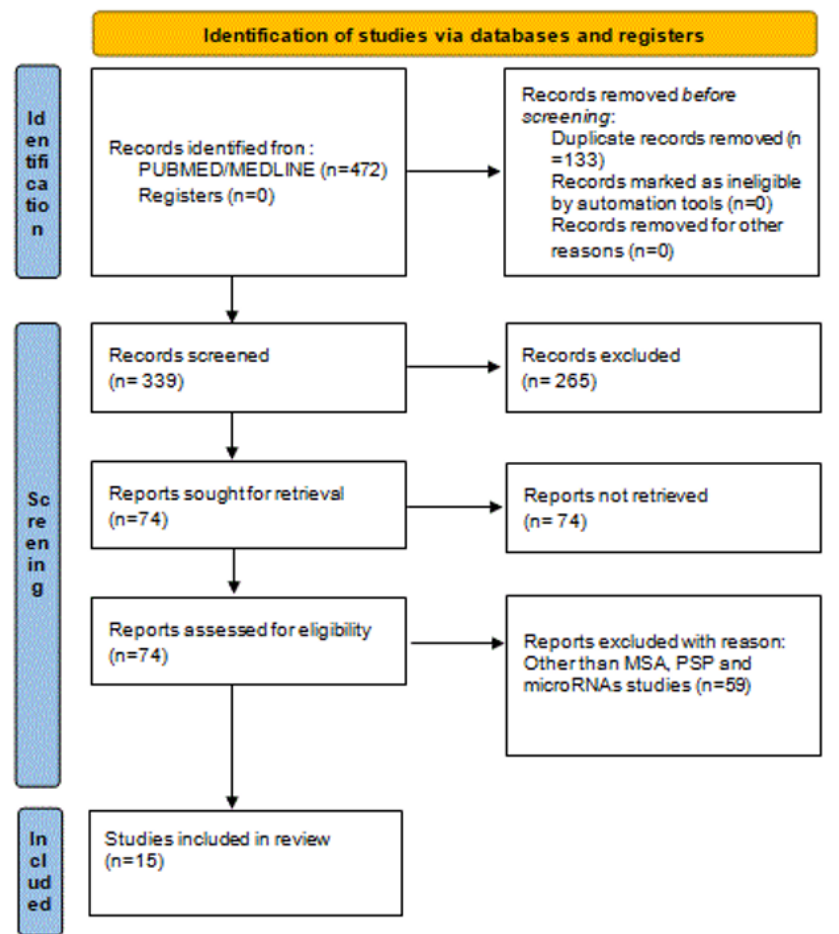
Figure 1. Identification of studies via using PRISMA flow diagram. Abbreviation: MSA: Multisystem Atrophy, PSP: Progressive supranuclear palsy.